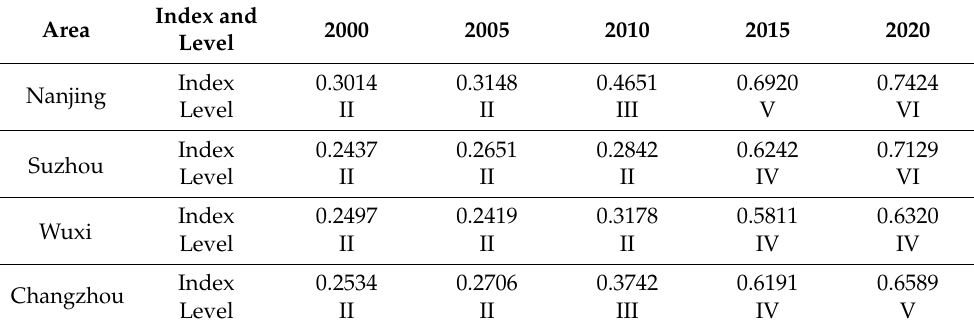
Table 4. Coordinated development index and evaluation level of cities in